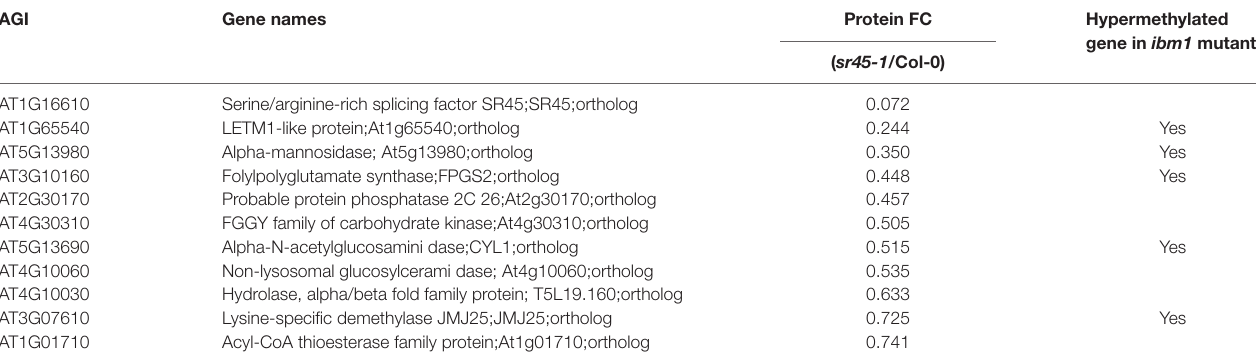
TABLE 2 | A summary of genes of which their RNAs are identified as SR45-associated (SAR) and SR45-dependent alternatively spliced (SAS), and of which their proteins are differentially accumulated in an SR45-dependent manner. The RNA for these proteins is not differentially expressed in the sr45-1 mutant (Zhang et al., 2017). AGI